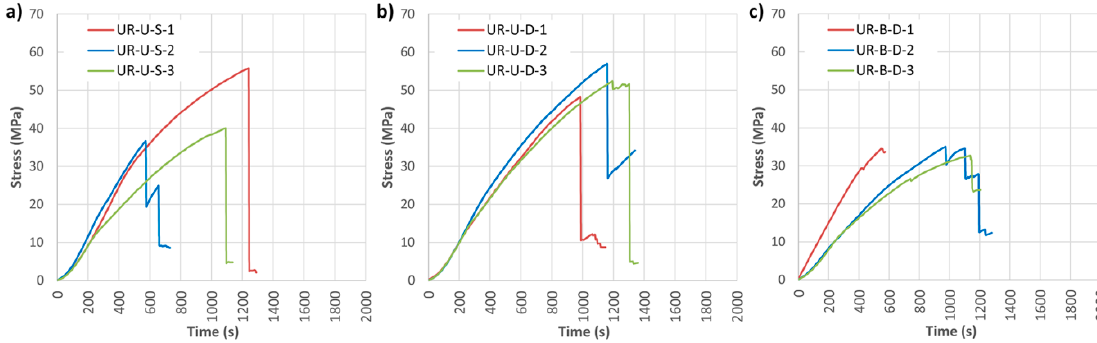
Figure 14. Bending stress against time for U-shaped reinforced beams (UR): ( a ) UR-U-S; ( b ) UR-U-D; and ( c ) UR-B-D. CFRP suppliers: SIKA ® and DRIZORO ® . Table 5. Mechanical results obtained from bending tests for UR-U-S, UR-U-D and UR-B-D beams. Visual classification, MOR, density, density-corrected MOR, MOE, maximum deflection and type of failure. CFRP suppliers: SIKA ® and DRIZORO ® .